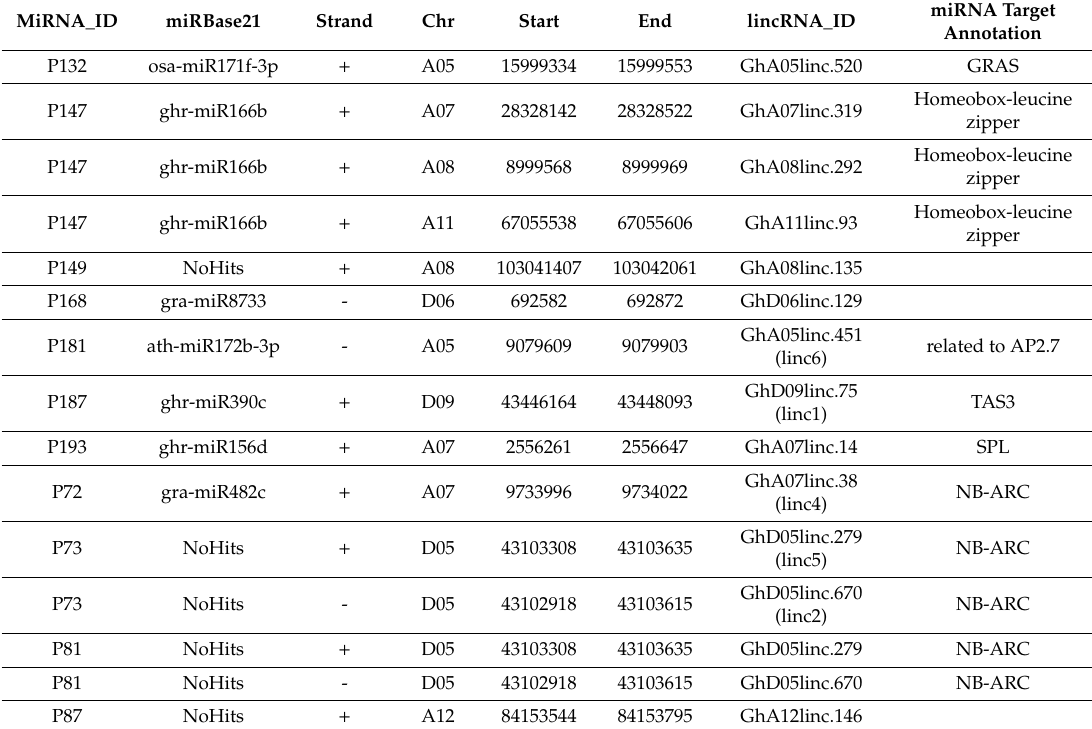
Table 2. The pre-miRNAs generated from lincRNAs in HR and ZS plants following whitefly